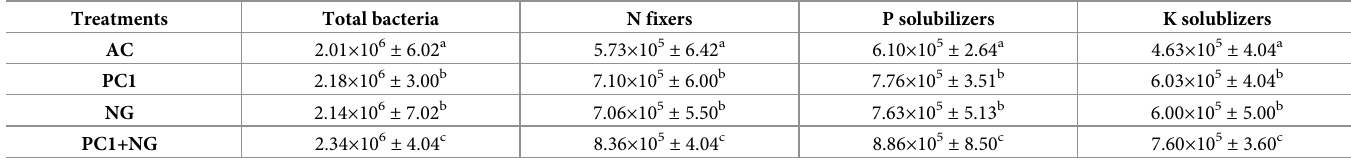
Means in each column followed by the same letter were not significantly different (P � 0.05) as determined by one-way ANOVA and Duncan’s Multiple Range Test (DMRT). Values were the means of three replications ± SD.